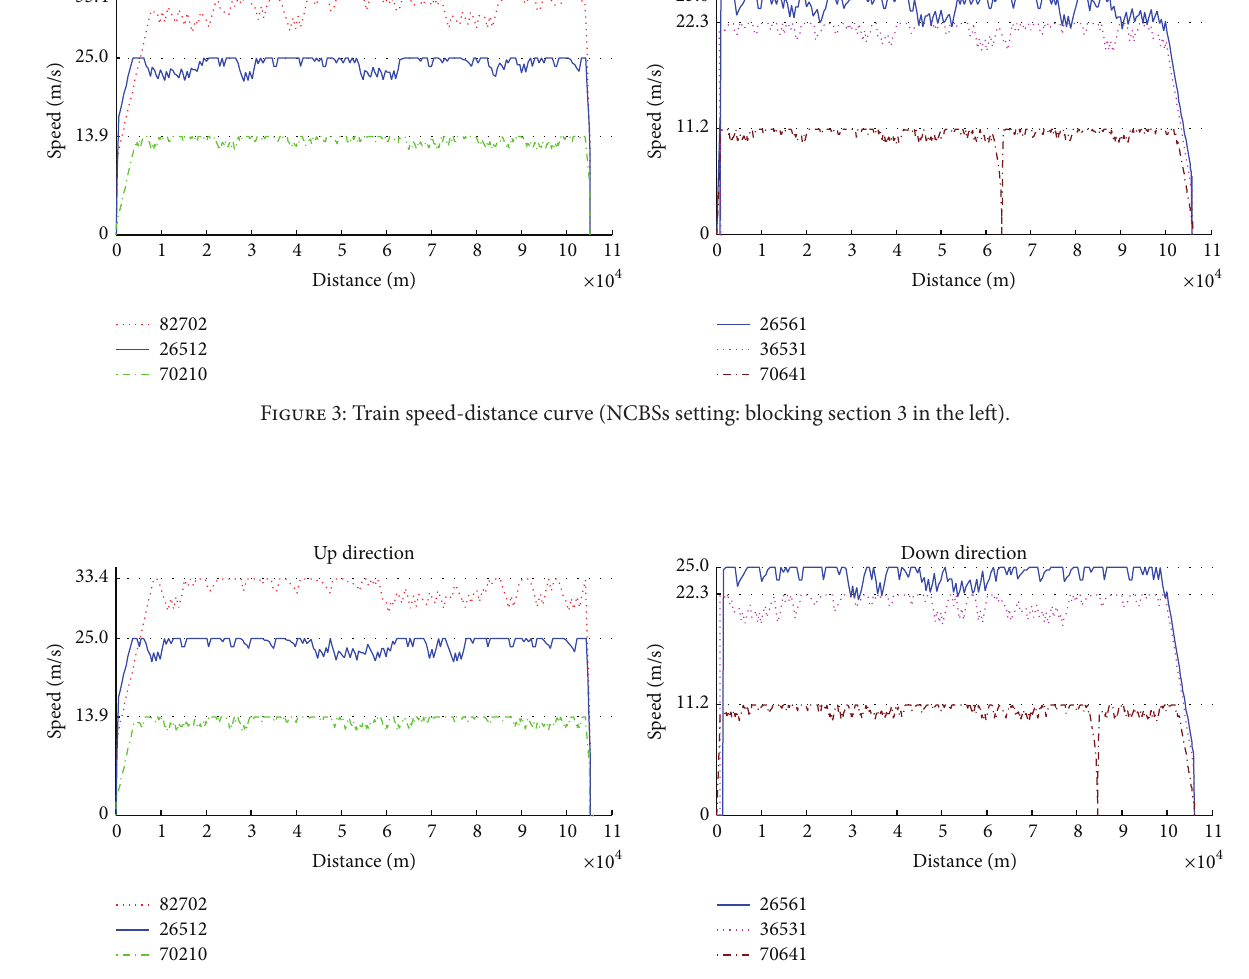
Figure 4: Train speed-distance curve (NCBS: blocking section 4 in the left).